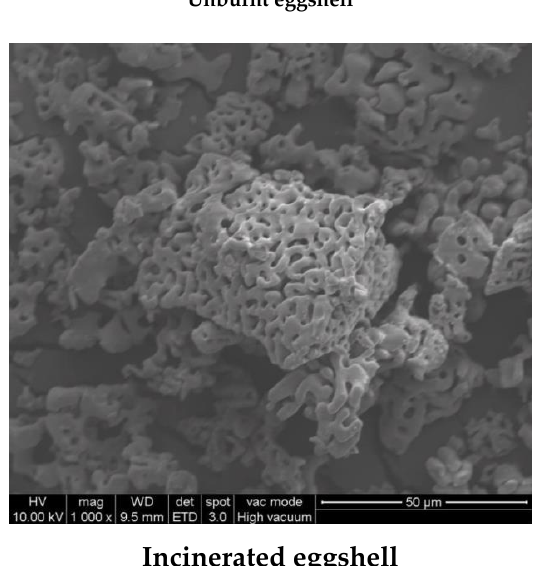
Figure 3. Material texture of eggshell, before and after incineration at high temperature.